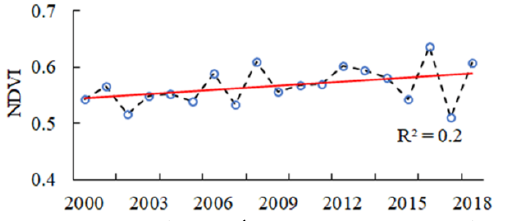
Figure 5. Variation of NDVI (June, July, and August of 2000- 2018).